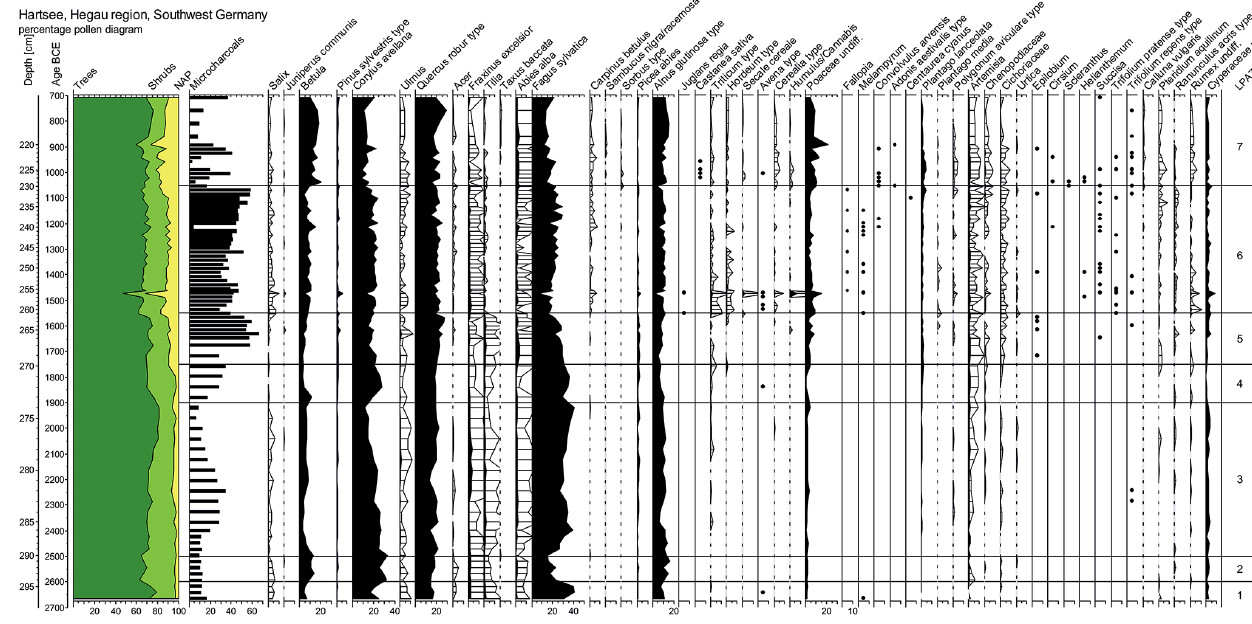
Figure 14. Pollen profile of Hartsee mire. NAP: non-airborne pollen. The samples were investigated in increments of